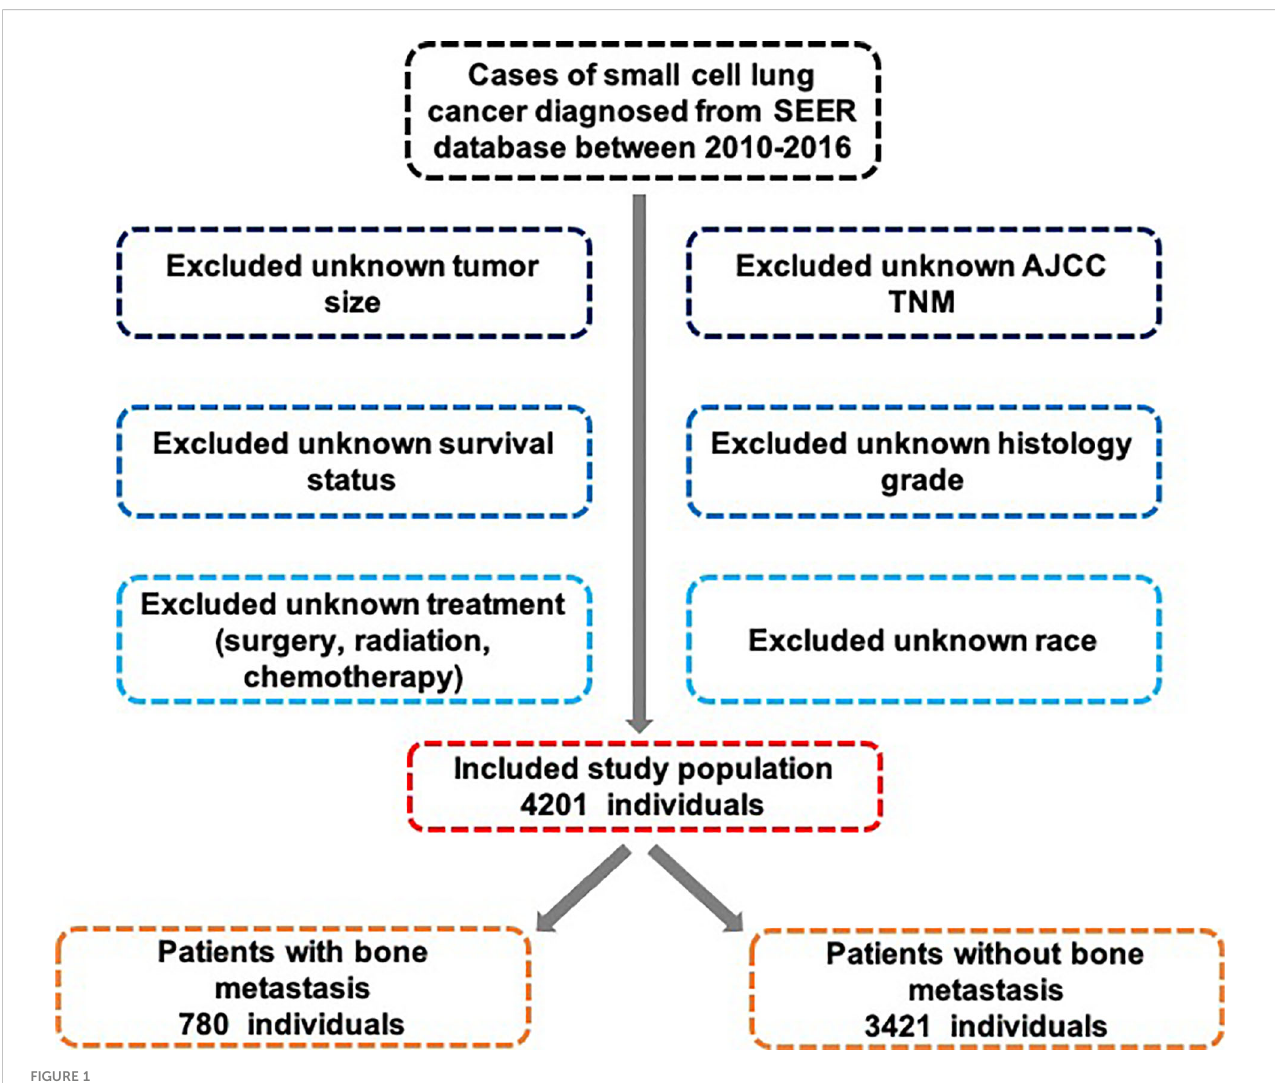
FIGURE 1 Deep learning process for SCLC patients with